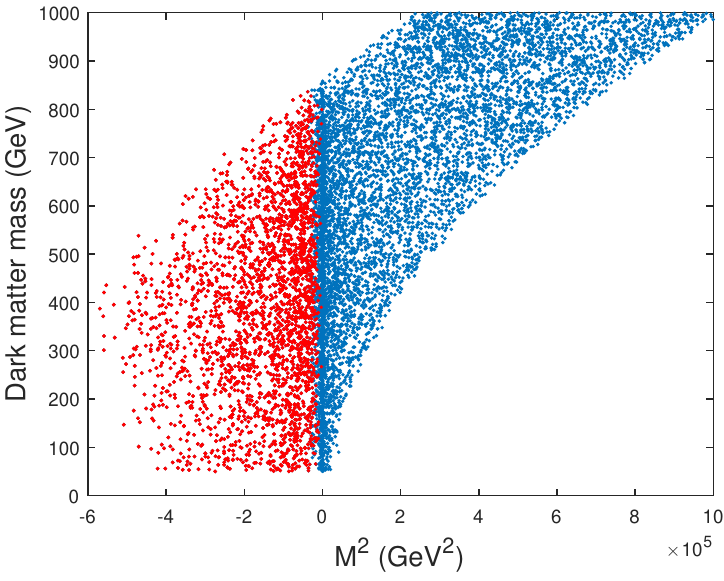
Figure 1 . Values of the dark matter particle mass as a function of the quadratic coupling M 2 for a minimum of type N 2. In blue, all the scanned points; in red, those points for which there exists a CB vacuum (of types CB 7 or CB 10) lower than N